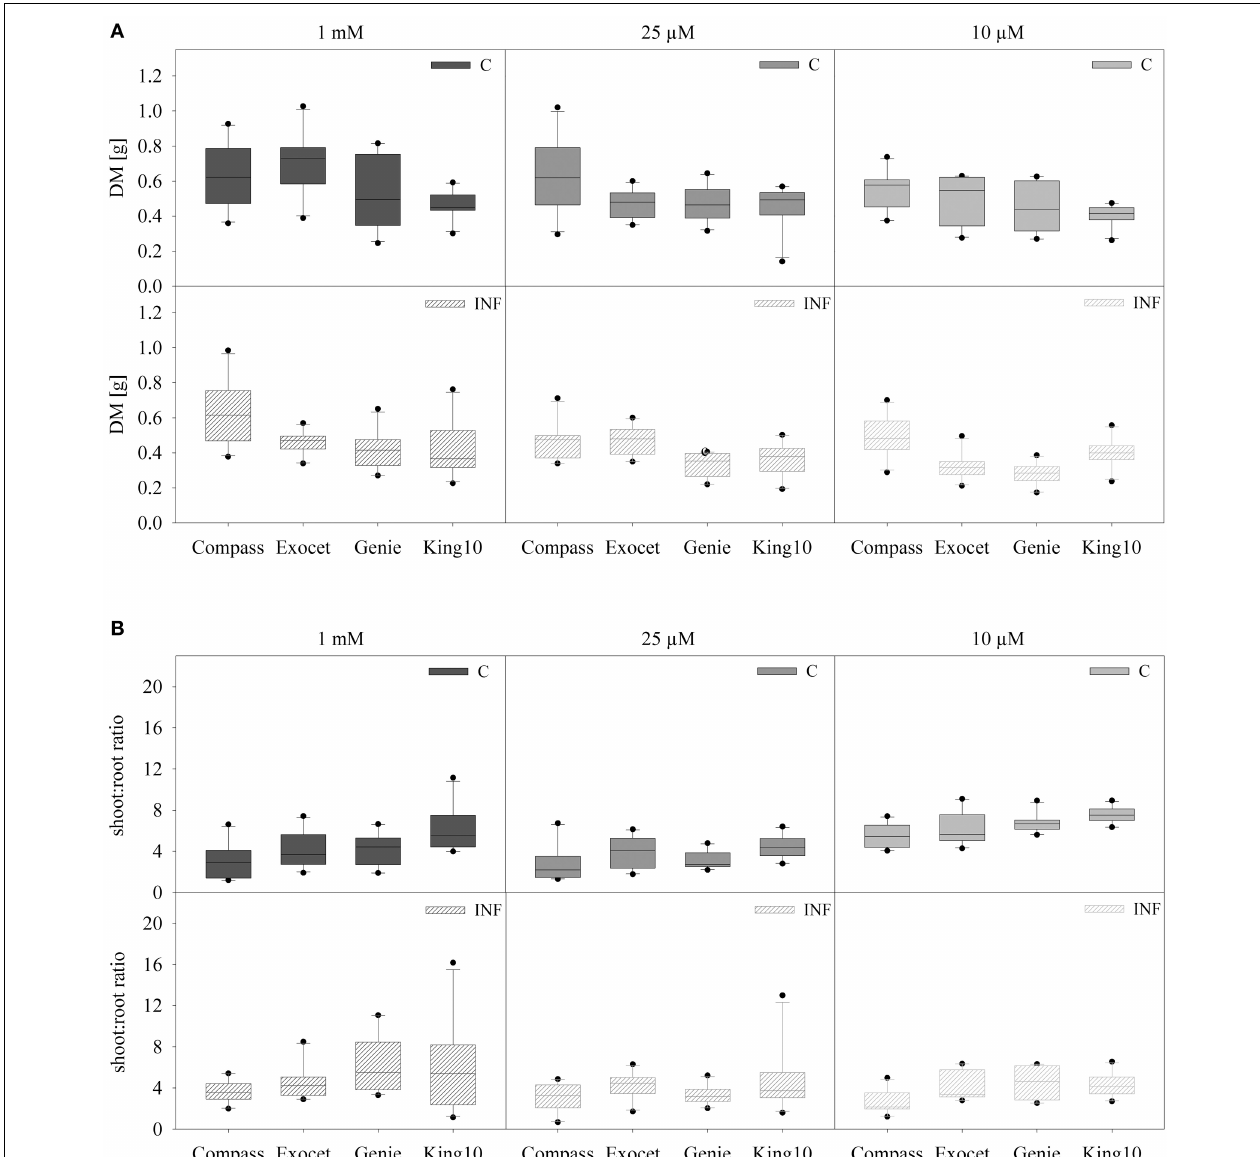
FIGURE 2 | Biomass analysis. Seven-day-old seedlings of the cultivars were either mock-inoculated (C) or infected with V. longisporum spores (INF). Plants were grown under full sulfur supply (1mM MgSO 4 ) and under sulfur limitation (0.025mM and 0.010mM MgSO 4 ) in a climate chamber for 14 dpi.